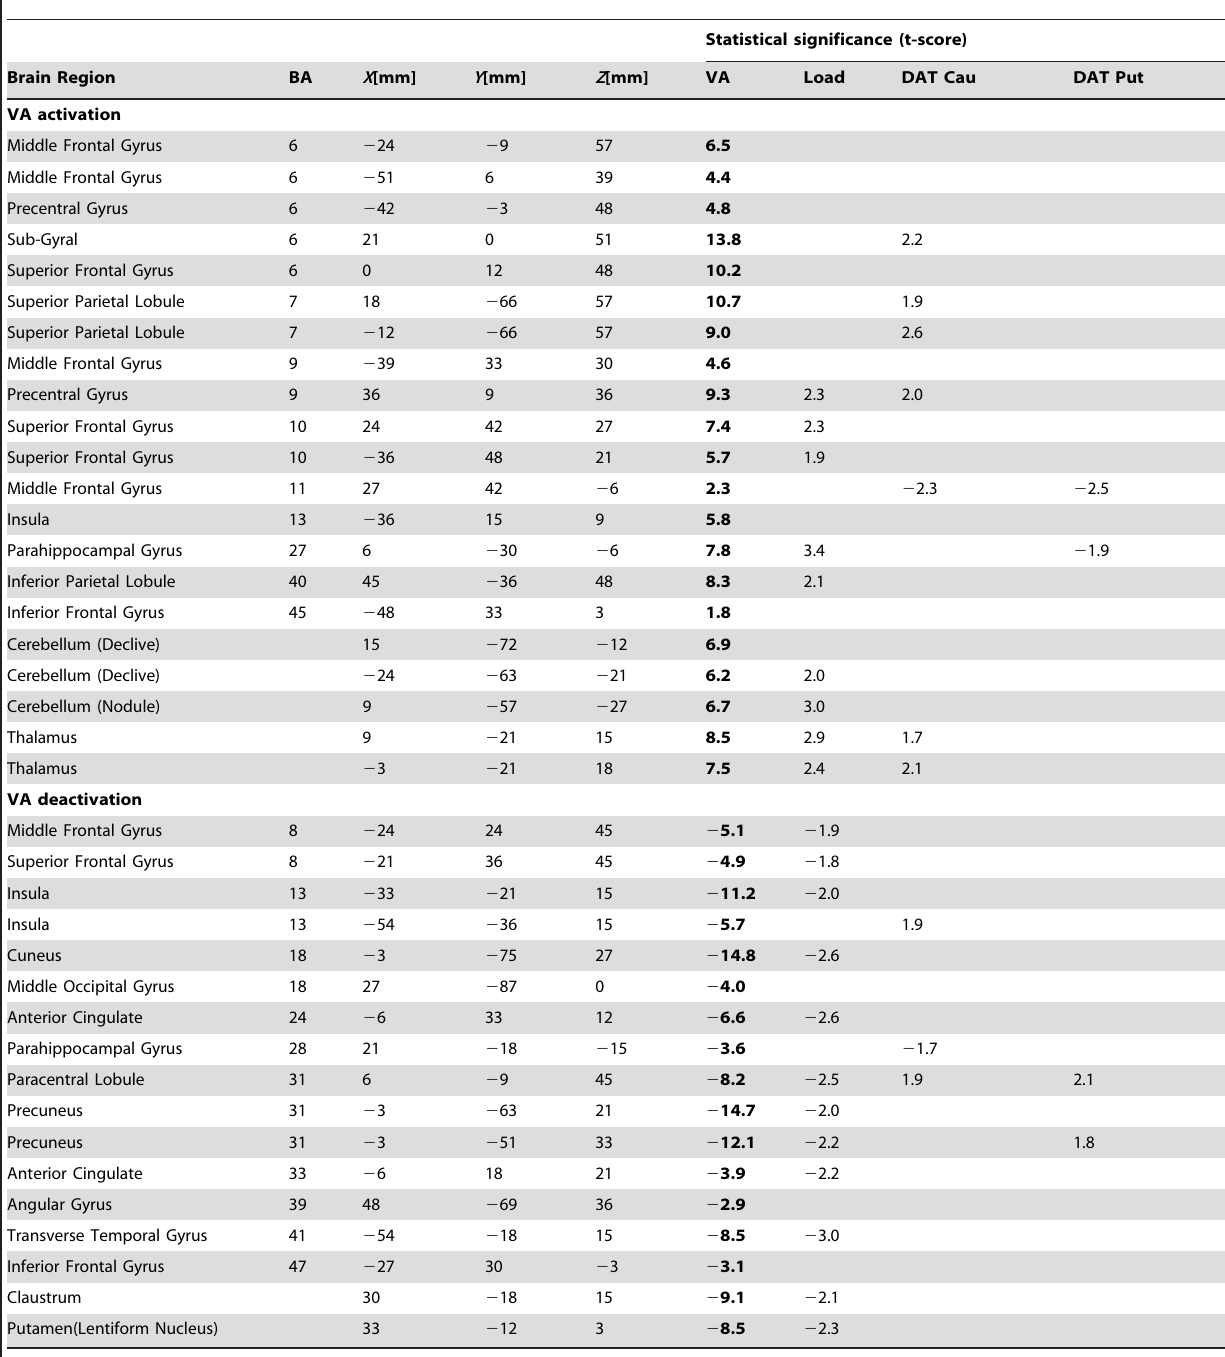
Table 1. Average statistical significance in regions-of-interest exhibiting BOLD-fMRI activation/deactivation.